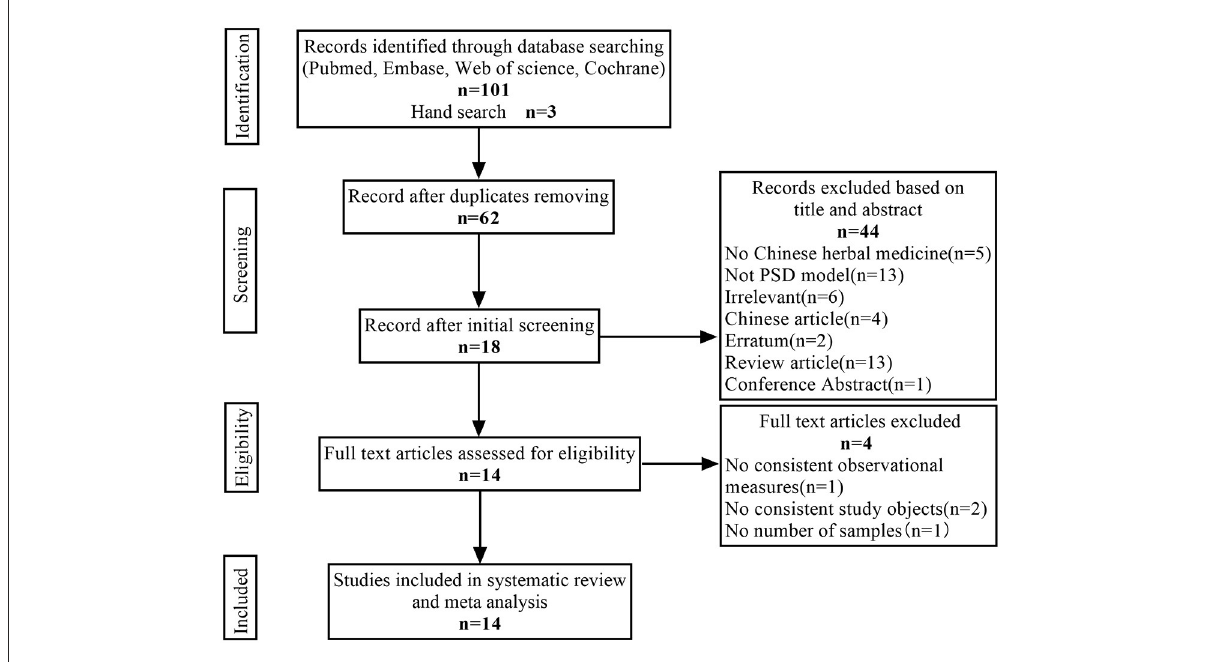
FIGURE1 Flow diagram of the study selection